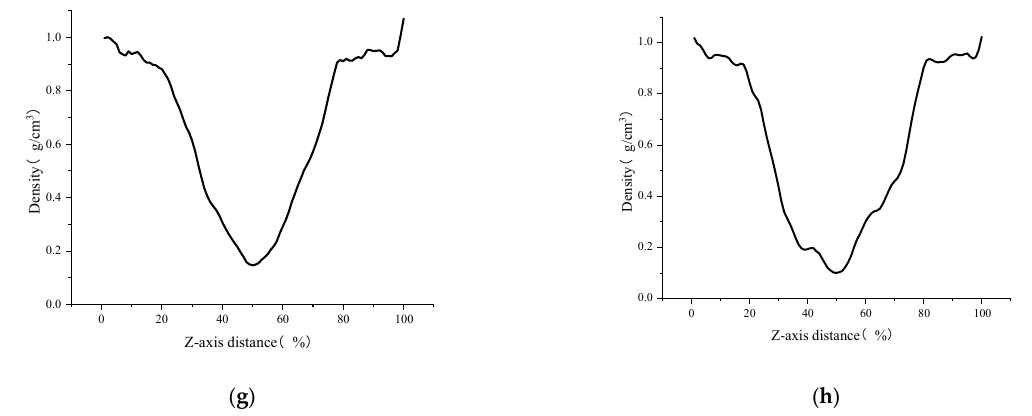
Figure 7. Distribution function of density on the z-axis under different strain conditions. ( a ) 0% strain; ( b ) 5% strain; ( c ) 10% strain; ( d ) 15% strain; ( e ) 20% strain; ( f ) 30% strain; ( g ) 45% strain; ( h ) 60% strain.